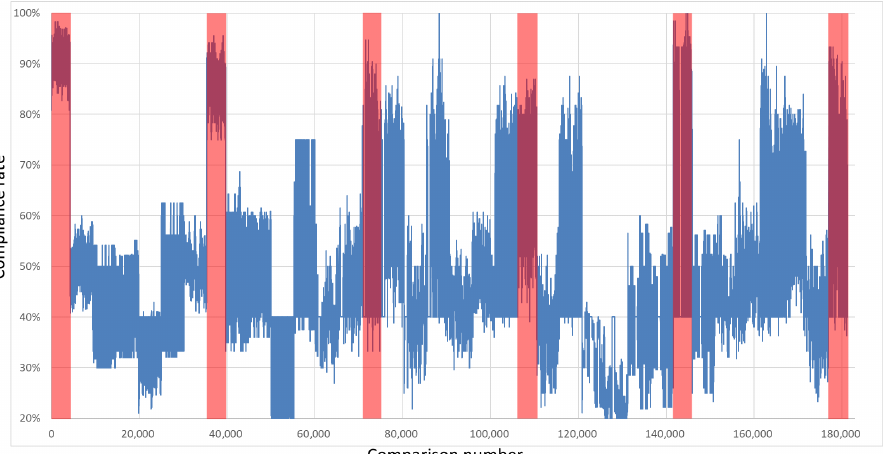
Figure 9. Results of the comparison of each key pair for all boards in a set—Intel MAX10 x 4 + x + 1.